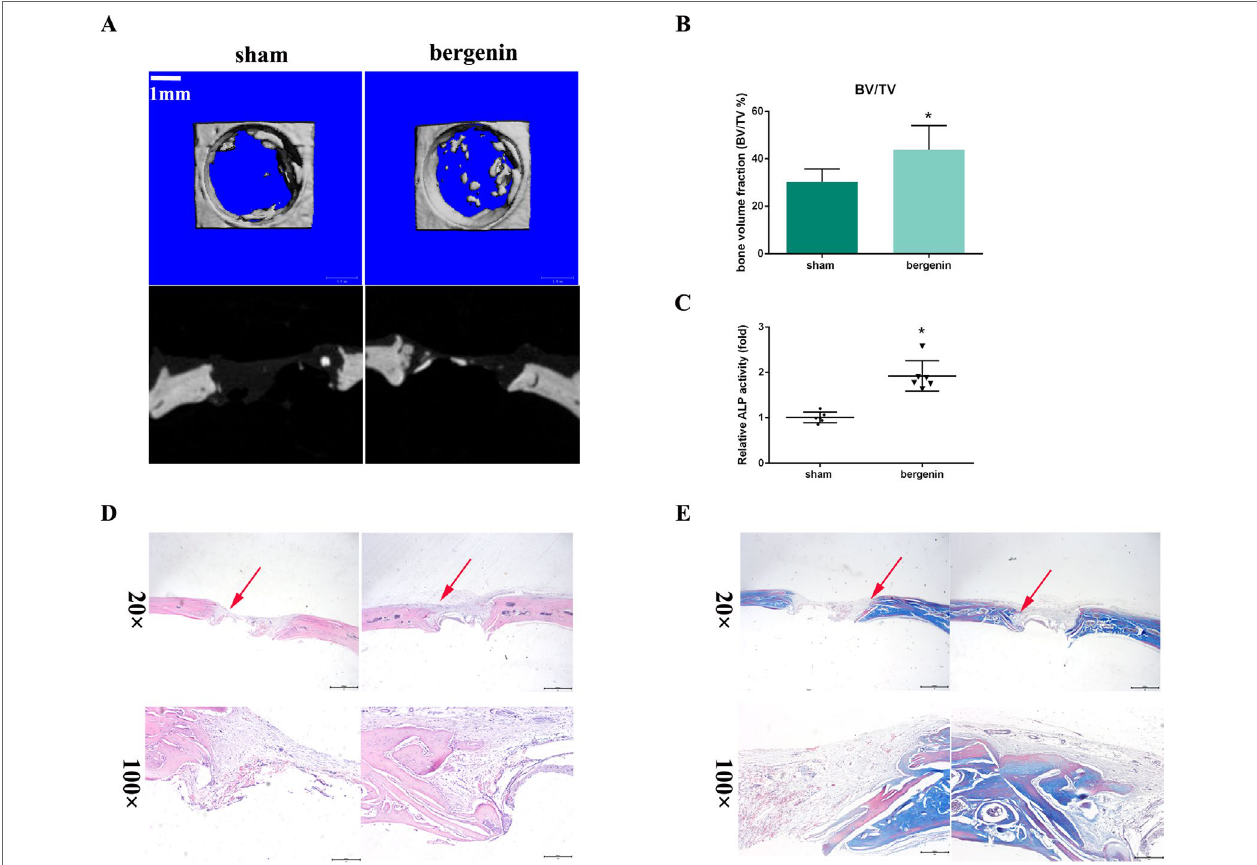
FIGURE 5 | Bergenin accelerated bone formation in a calvarial defect model in rats. (A) Microcomputed tomography analysis for bone healing. (B) Bone volume was analyzed by microcomputed tomography. Data are expressed as the mean ± standard deviation (SD). Reactions were performed in triplicate. * P < 0.05 vs. bone defects with PBS (sham group). (C) ALP activity in serum, * P < 0.05 vs. bone defects with PBS (sham group). (D) Histologic analysis for bone healing. HE, hematoxylin and eosin staining; Magnification × 40 (bar = 500 μm) and × 100 (bar = 200 μm). (E) Masson, Masson’s trichrome staining. Magnification × 40 (bar = 500 μm) and × 100 (bar = 200